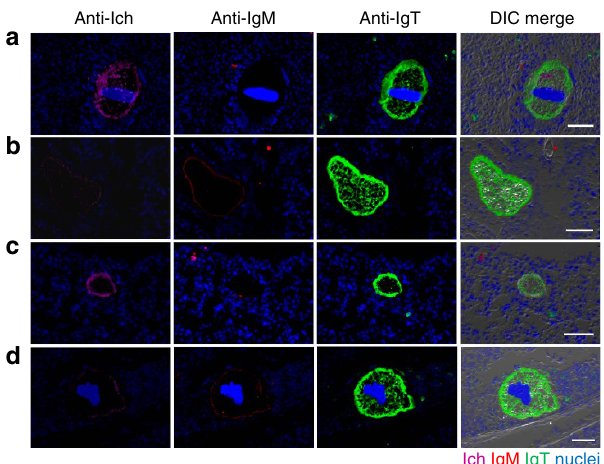
Figure 3 | Parasites are mainly coated by IgT in the gill of infected trout. Four different microscope images ( a – d ) of slides showing immunofluorescence staining of Ich parasites in gill cryosections from trout infected with Ich after 25 days ( n ¼ 6). From left to right: Ich (magenta), IgM (red) and IgT (green) with nuclei stained with DAPI (blue); DIC images showing merged staining (isotype-matched control antibody staining, Supplementary Fig. 4a online). Scale bars, 20 m